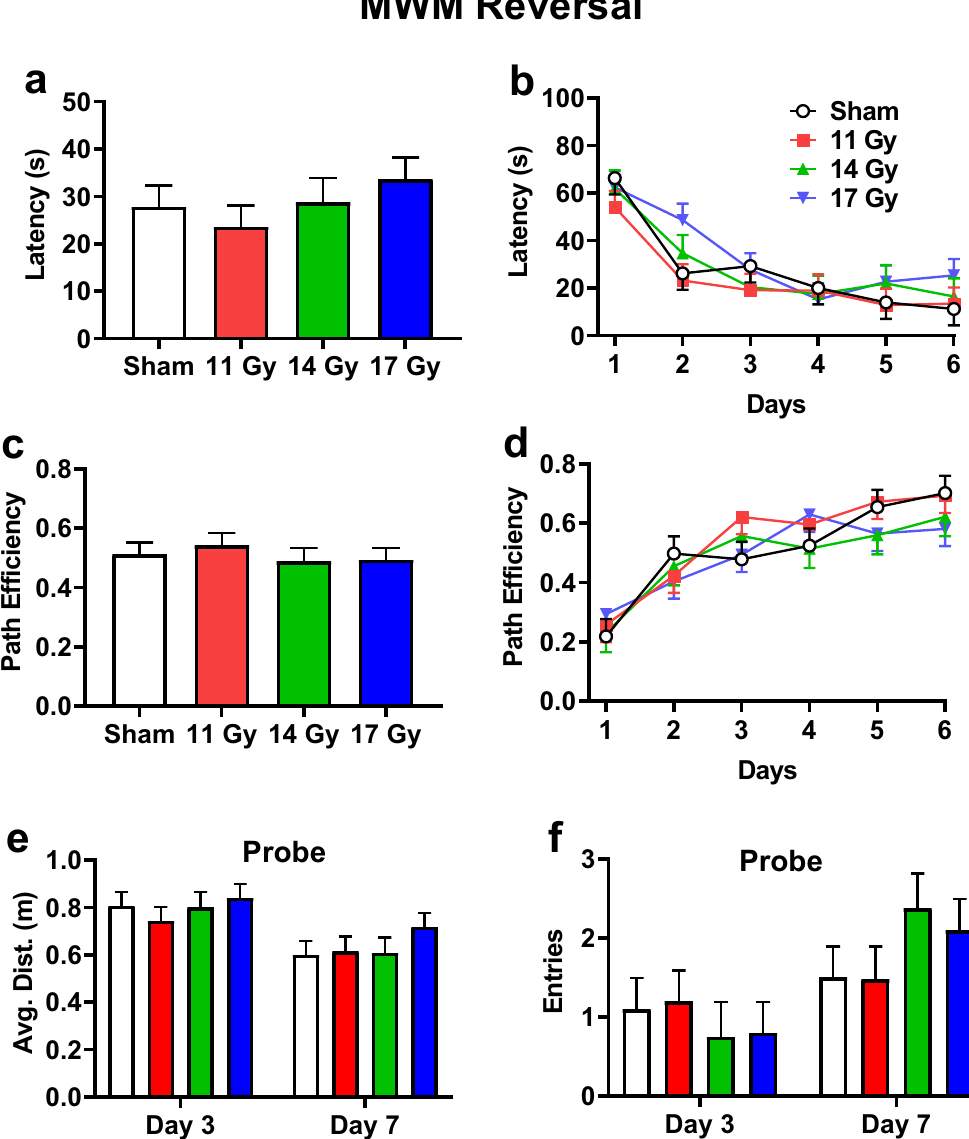
Figure 8. Reversal phase Morris water maze performance in proton irradiated and control rats. ( a ) Overall effect on latency to the platform. ( b ) Learning curve for latency with all groups. ( c ) Overall effect on path efficiency. ( d ) Learning curve for path efficiency. e. Average distance from the former platform site on day-3 and -7 probe trials. ( f ) Number of entries into the former platform site on day-3 and day-7 probe trials. No group differences were found. N = 10/control, 11 Gy, and 17 Gy and n = 8 for the 14